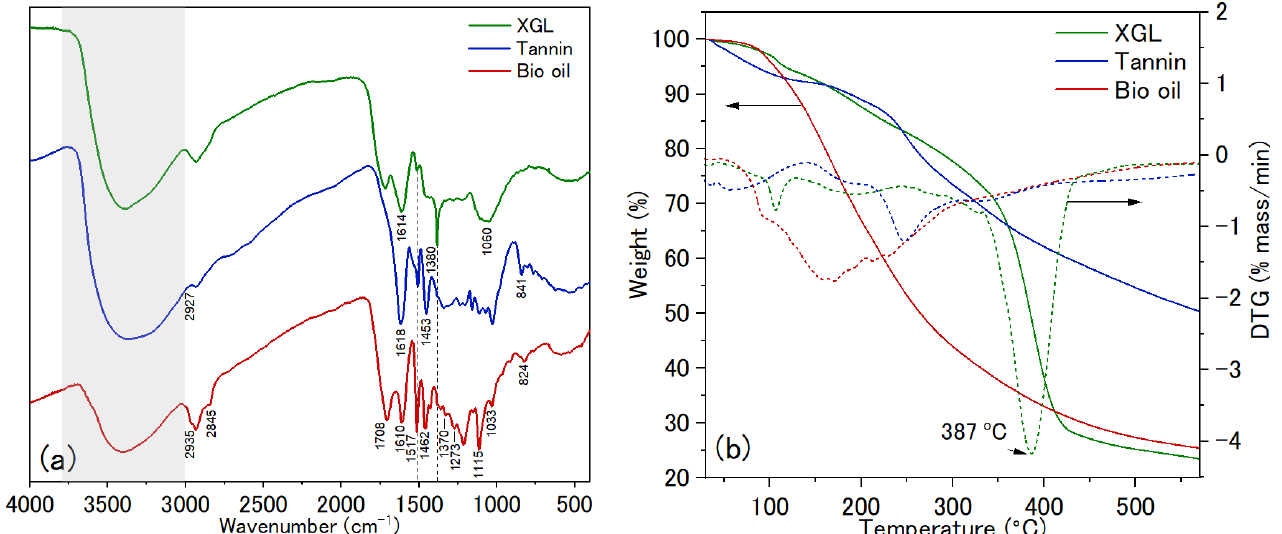
Figure 1. ( a ) FTIR spectra and ( b ) thermal analysis TG/DTG of bio-oil, tannin and XGL.